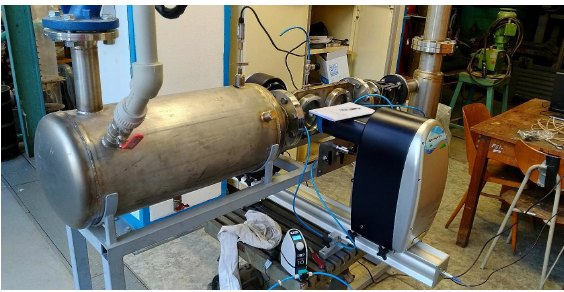
Figure 5. The Spraytec position on the wind